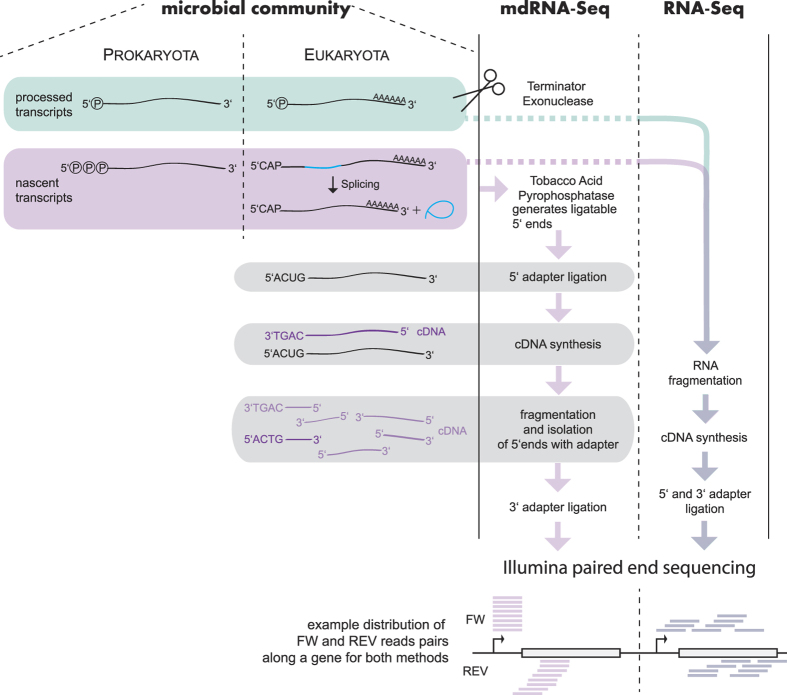
Comparative overview of the transcript library preparation for mdRNA-Seq and RNA-Seq from the microbial community.Seawater was pre-filtered in the shade through a 20 μm mesh to keep out larger material and then onto polyethersulfone filters of 0.45 μm pore size. After isolation of total RNA, RNase treatment and cDNA synthesis, the samples were paired-end sequenced on an Illumina HiSeq 2000 platform with a read-length of 100 nt. An example of the theoretical read distribution over a protein-coding gene and its 5′ UTR is given at the bottom. The arrows mark the TSSs. Only steps important for understanding are sketched; cDNA amplification steps were omitted. 5′ adapter sequences are indicated as “ACUG”.